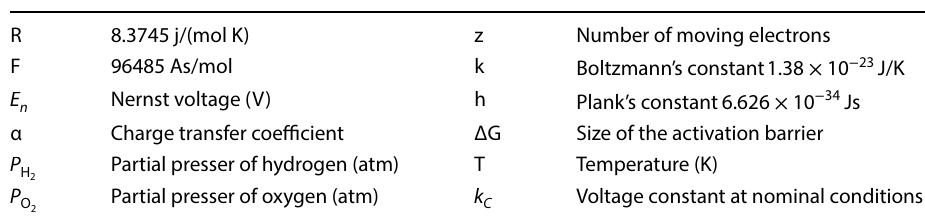
Measure V(K), I(K) Calculate P, dP and dV P=V(K).I(K)